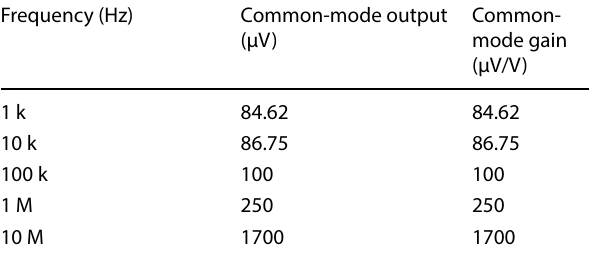
Table 5 Common-mode gain for 1–10 MHz